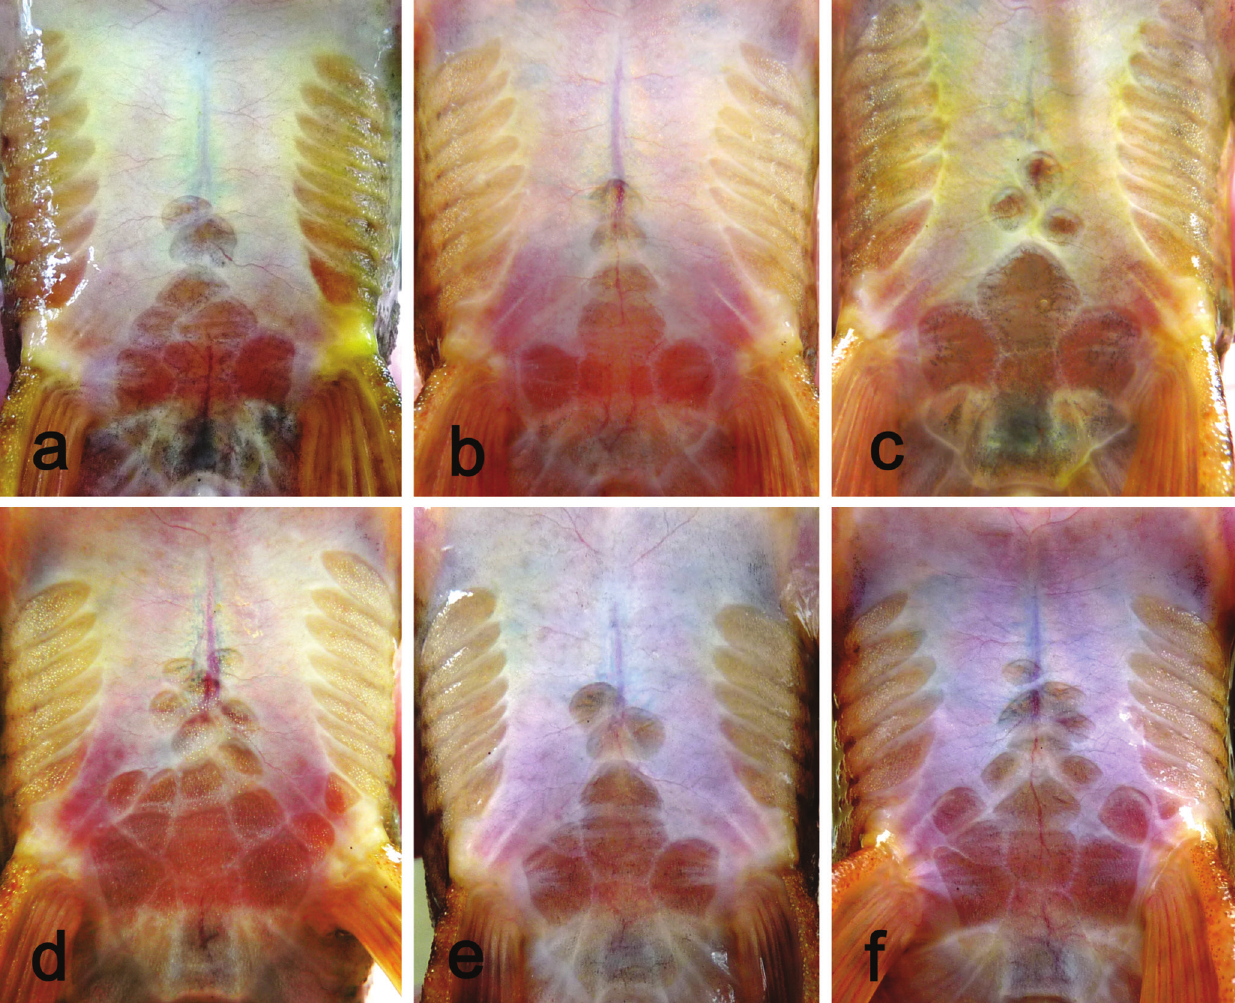
Fig. 3. Variation in number, shape, size and organization of the bony plates covering the abdominal surface of six different Rineloricaria aequalicuspis individuals with more than 10 cm total length. These are examples of photographs taken during the field test. (a) 175 mm TL; (b) 138 mm TL; (c) 156 mm TL; (d) 145 mm TL; (e) 141 mm TL; (f) 151 mm